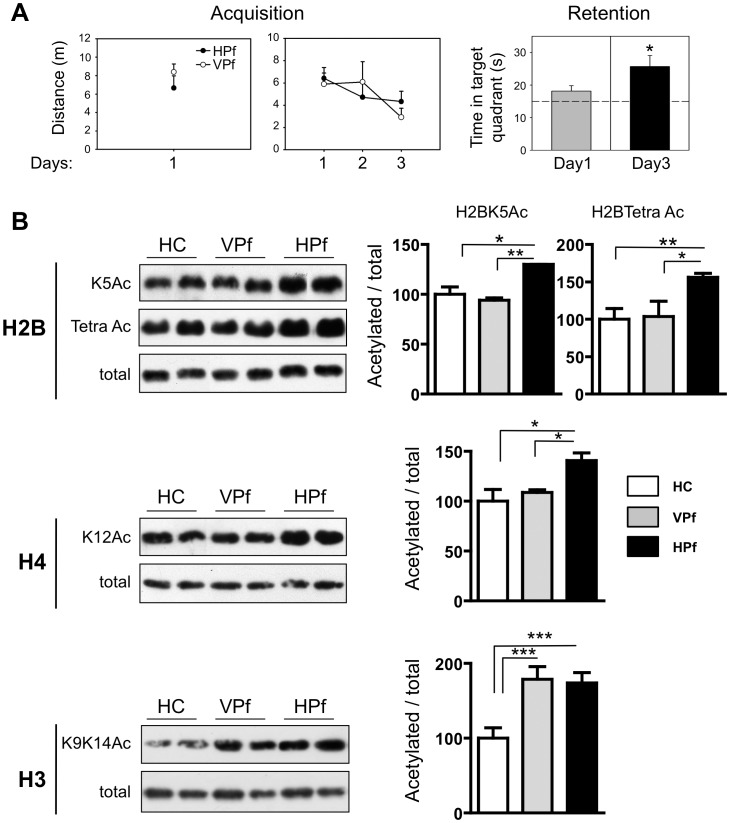
Short spatial memory training differentially modulates histone acetylation in the rat hippocampus.(A) Performance of rats trained in the Morris water maze task during one or three consecutive days in the Morris Water Maze (left panel) and probe trial performance after 1 or 3 days of training (right panel). During training, rats had to search for the location of a platform hidden at a constant location (HPf); their controls swam to a visible platform (VPf) whose location was changed from trial to trial. Probe trial performances of the HPf groups are presented after 1- or 3 days of training (right panel) as the mean time (+ SEM) spent in the target quadrant. After 3 days of training, the rats trained with the hidden platform performed significantly above chance (i.e., 15 s), *p<0.05, an effect not observed after only 1 day of training. (B) Comparison of acetylated and total histone levels between home cage rats (HC, n = 5), rats trained to swim to a visible platform (VPf, n = 5) and rats trained to learn the location of a hidden platform (HPf, n = 5) in a single daily session (4 trials). Acetylation levels were measured by western blot performed on total extracts from dorsal hippocampus with specific antibodies (Tetra Ac: H2BK5K12K15K20, K5Ac: H2BK5, H4K12 and H3K9K14). Typical western blots are presented in duplicates on the left. Corresponding quantifications are shown on the right. Ratios of acetylated/total histone corresponding to the home cage rats (HC) were arbitrarily set at 100% and other values normalized accordingly. Newman-Keuls multiple comparisons test: ***p<0.001, **p<0.01, *p<0.05, for comparisons with the HC group or as indicated. Both H2B and H4 histones showed hyperacetylation in the group trained to find the hidden platform (HPf) compared to either control (VPf or HC), while H3 was hyperacetylated in the VPf and HPf groups, thus more reflecting task-related context processing.